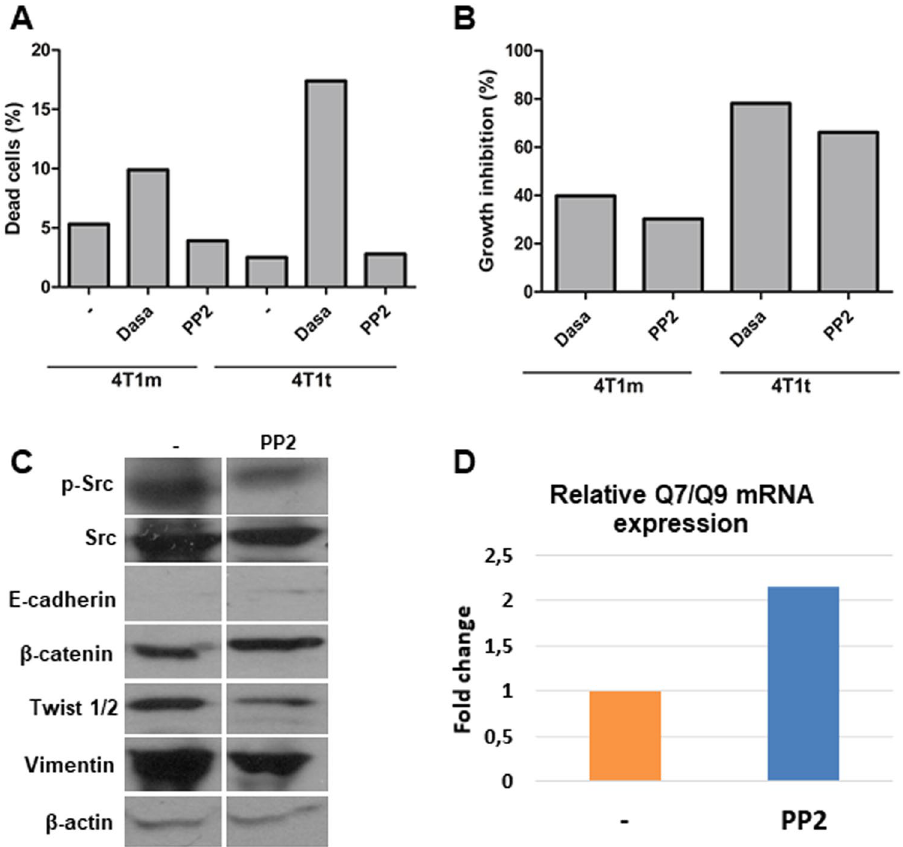
Figure 5. Pharmacological inhibition of Src enhances Qa-2 expression. ( A ) Effect of Src inhibitors on cell viability. 4T1t and 4T1m cell cultures were treated with Dasatinib (Dasa; 100 nM) and PP2 (5 μ M) for 48 h, and cell viability was determined by Trypan blue exclusion. Values represent the means of duplicate incubations. ( B ) Effect of Src inhibitors on cell growth. Cultures were treated as specified in panel A, and cells were counted at the end of the experiment. ( C ) Effect of PP2 (5 μ M) on the expression of Src and EMT protein markers of 4T1t cells. Protein levels were determined by Western blot analysis. β -actin was used as a control for protein loading. ( D ) Analysis of Q7/Q9 mRNA expression. Transcript levels were measured by real-time qRT-PCR, normalized to β -actin mRNA levels, and values for PP2-treated cells were compared to untreated cells, which were given an arbitrary value of